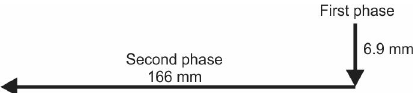
Figure 7. The scheme of the tool movement in the numerical simulations.